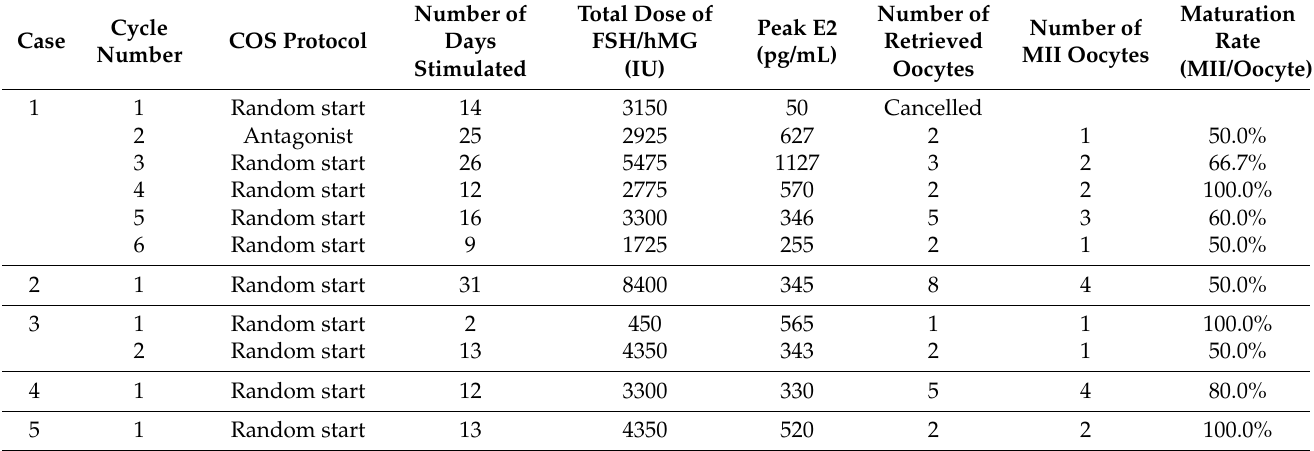
Table 3. Oocyte cryopreservation